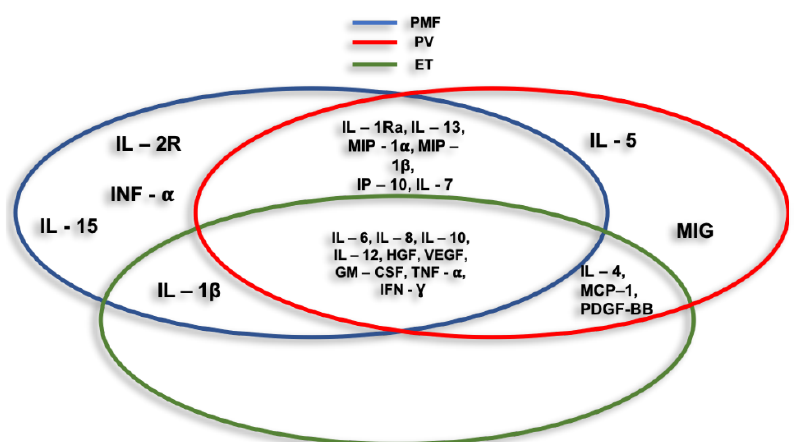
Figure 3. Cycles represent cytokines and chemokines associated with myeloproliferative neoplasms (MPNs) main entities.